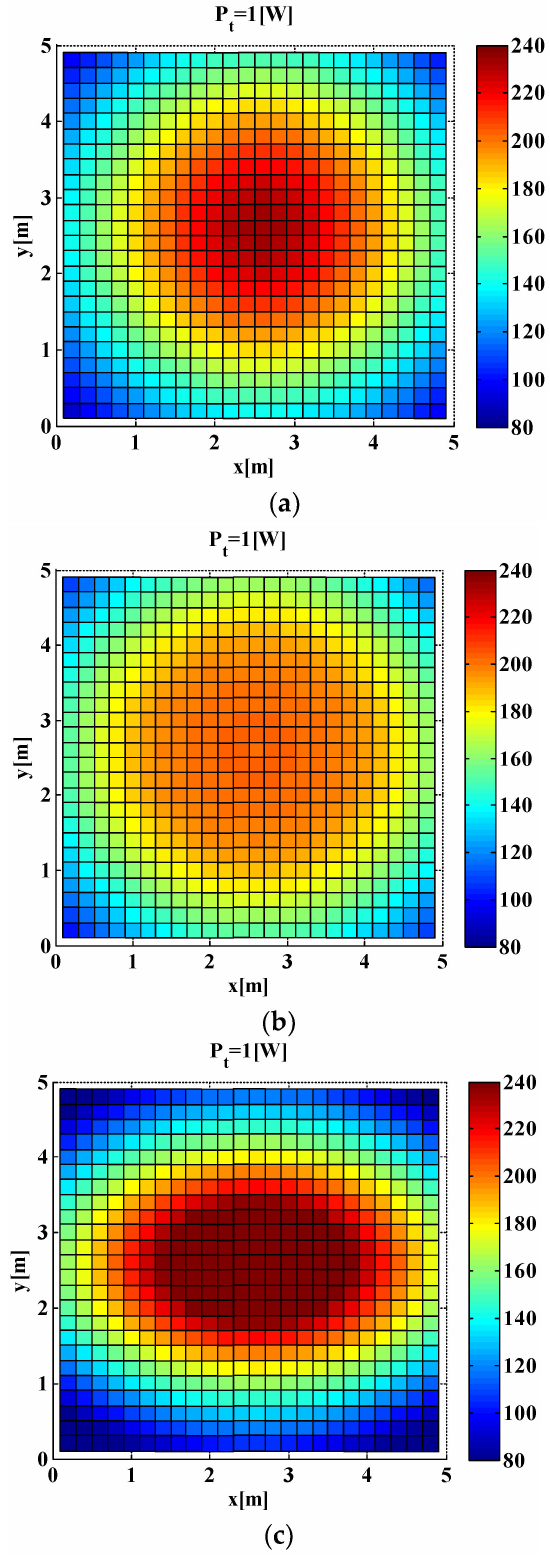
Figure 9. VLC link throughput spatial distribution for ( a ) Lambertian optical beam configuration, ( b ) LUXEON Rebel optical beam configuration, and ( c ) asymmetric NSPW optical beam